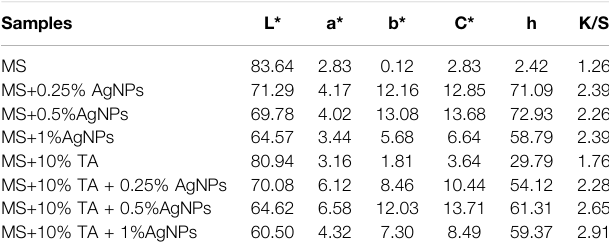
TABLE 5 | Fastness ratings of the dyed cotton fabrics with and without AgNPs (MS 50% o.w.f.). Samples